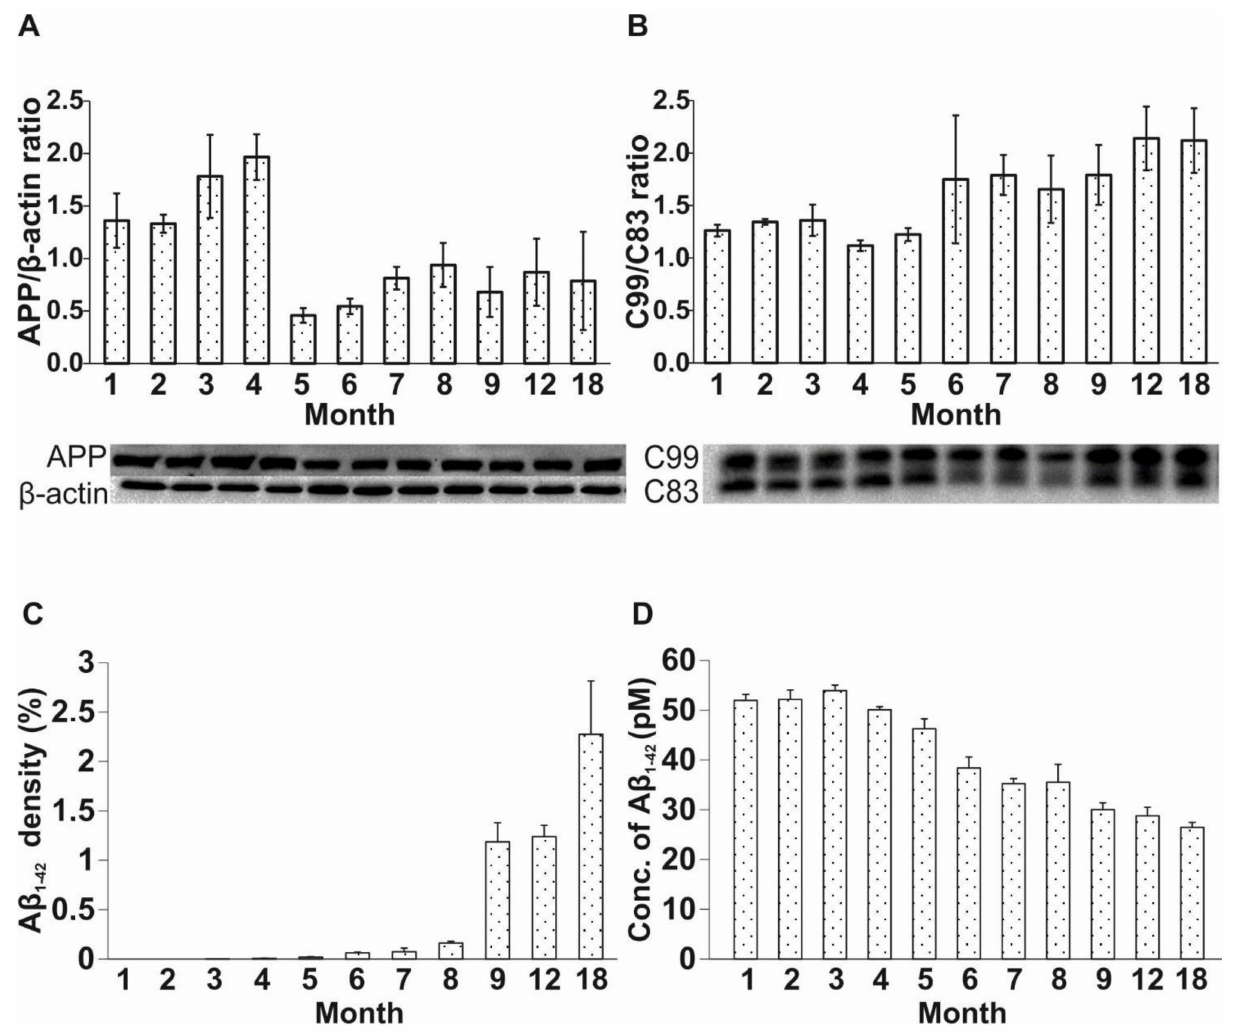
Figure 3. Measurement of APP, C99/C83 ratio by WB, soluble A β 1-42 by ELISA and plaque density by immunohistochemistry. ( A ) APP level was elevated in APP/PS1 animals from months 1 to 4, then decreased in 5- to 18-month-old mice. ( B ) C99/C83 ratio was elevated in Tg animals, starting from 5 months of age. ( C ) A β plaques appeared in APP/PS1 mice at 4 months of age. ( D ) The concentration of soluble A β 1-42 decreased in APP/PS1 mice in the 5- to 18-month-old age groups. Data represent mean ±